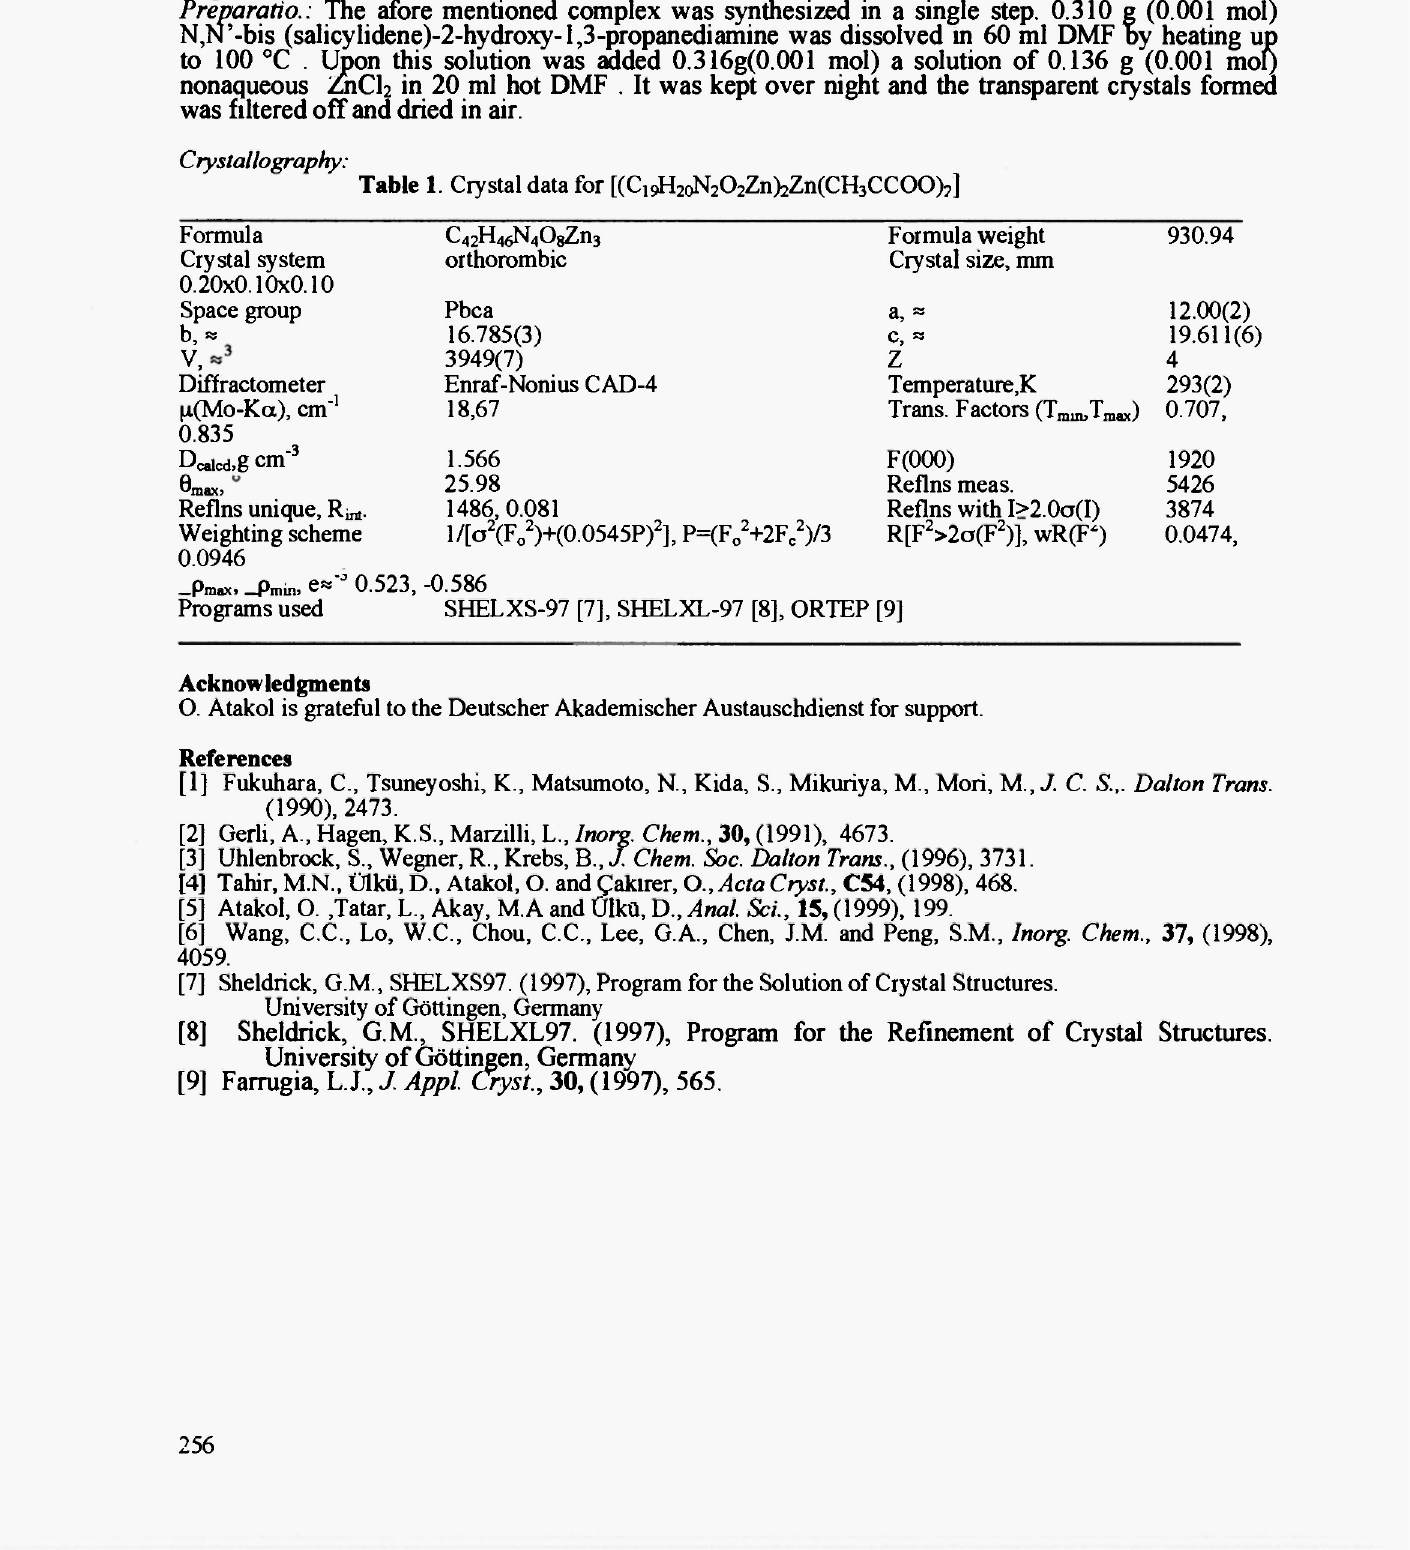
Crystallography: Table 1. Crystal data for